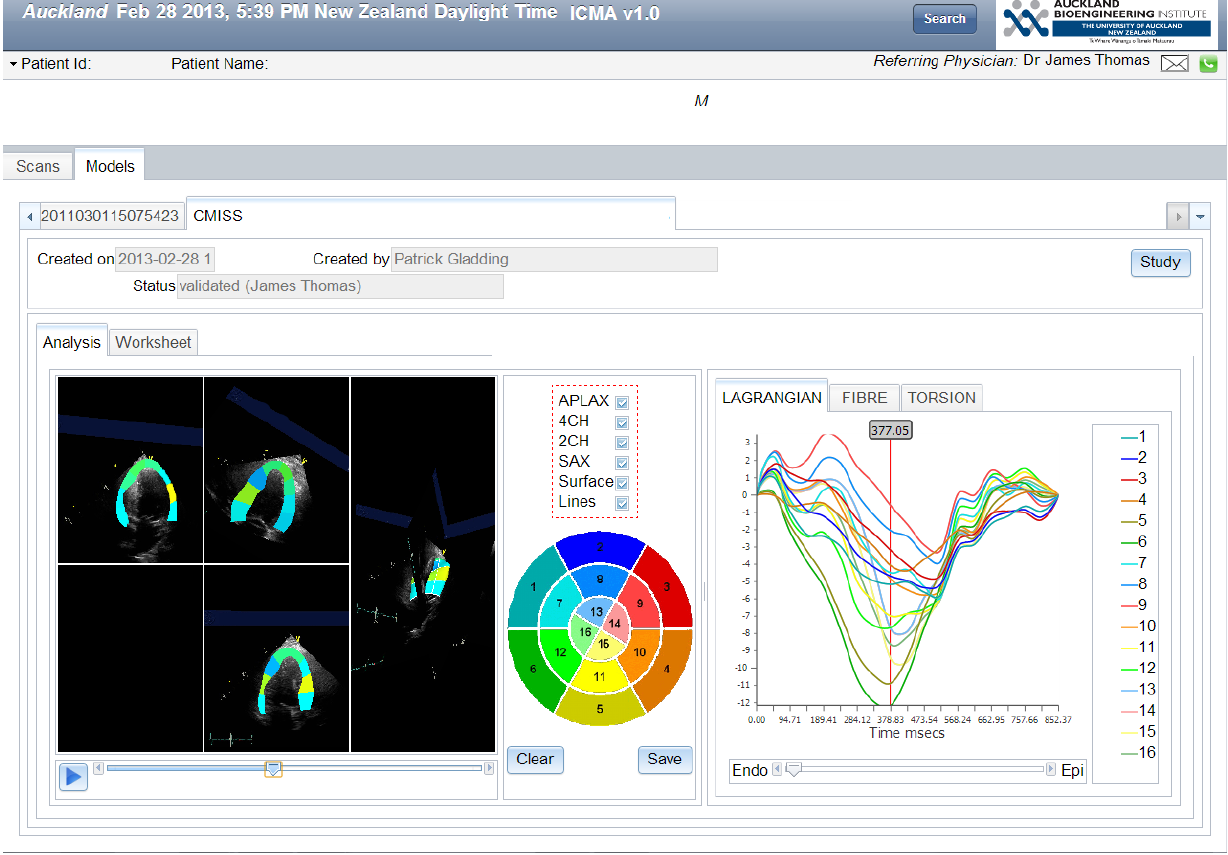
Figure 12. Left ventricular global longitudinal strain (Software engineering by Jagir